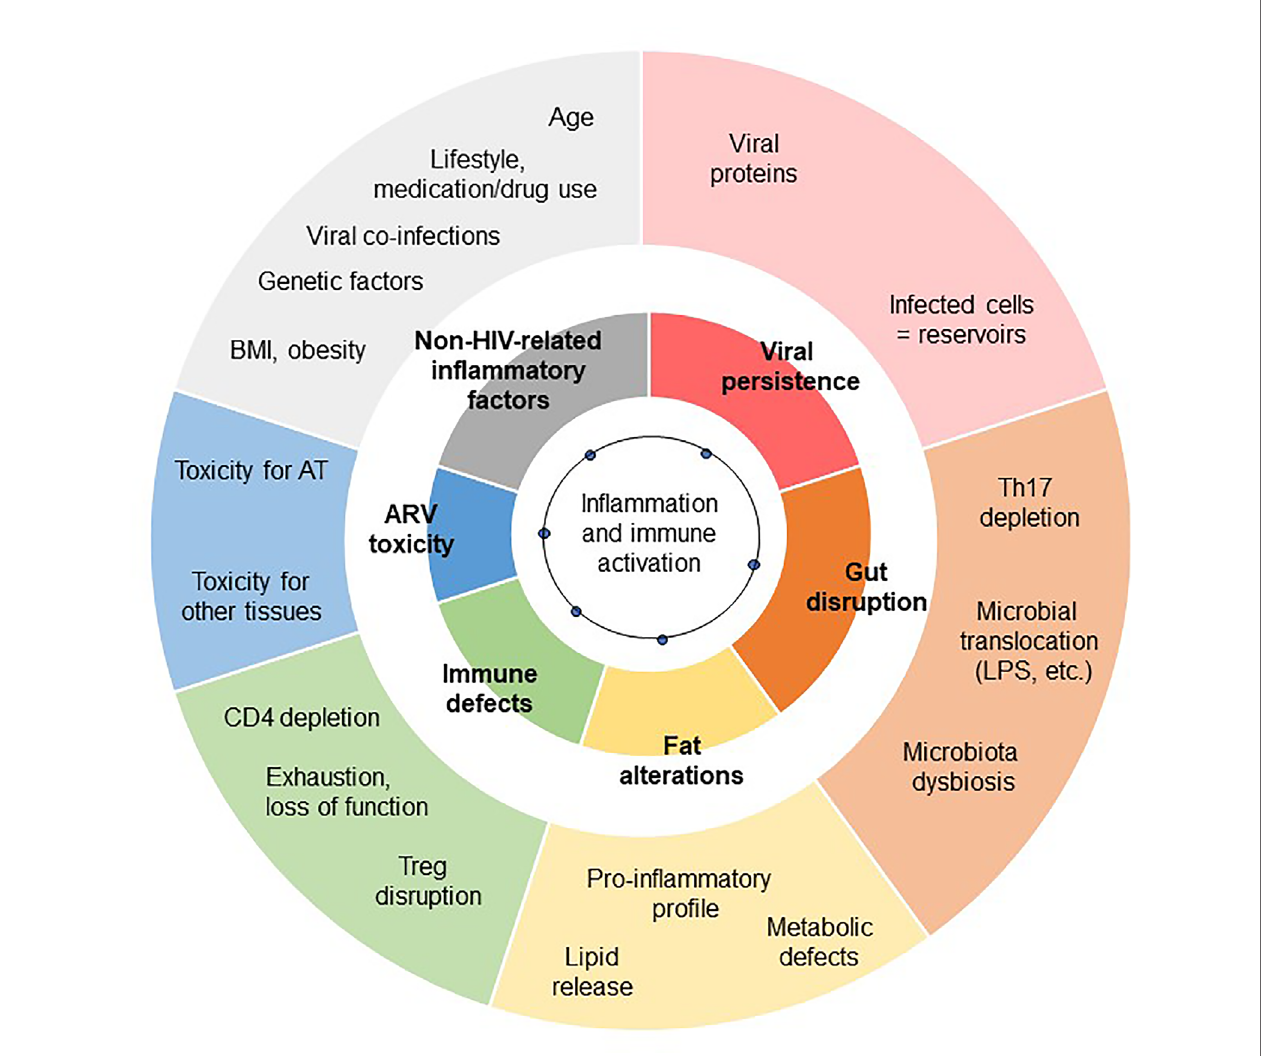
FIGURE 2 | Contribution of AT dysfunction to HIV-related low-grade in fl ammation. The exact degree of low-grade in fl ammation associated with chronic, controlled HIV infections remains subject to debate. The in fl ammation pro fi le depends on the biomarkers studied and the clinical context of chronic HIV infection (including the time of ART initiation, and the severity of the primary phase of the infection). However, various triggers of in fl ammation are commonly reported to contribute to low- grade chronic in fl ammation: viral persistence, gut disruption, immunoregulatory defects, and non-HIV related comorbidities. Each of these main factors (shown in the inner circle) has several subfactors (shown in the outer circle). Fat alterations and the toxicity of ARVs also